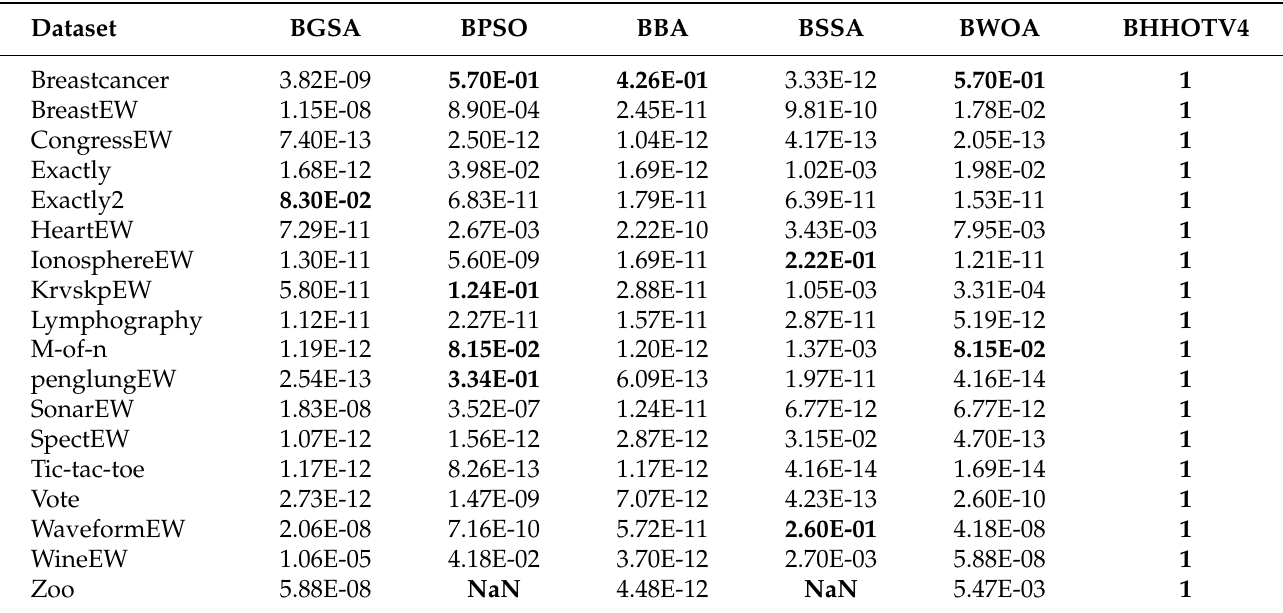
Table 8. The 2-tailed p -values of the Wilcoxon signed ranks test for accuracy results reported in Table 7 ( p -values ≤ 0.05 are significant).